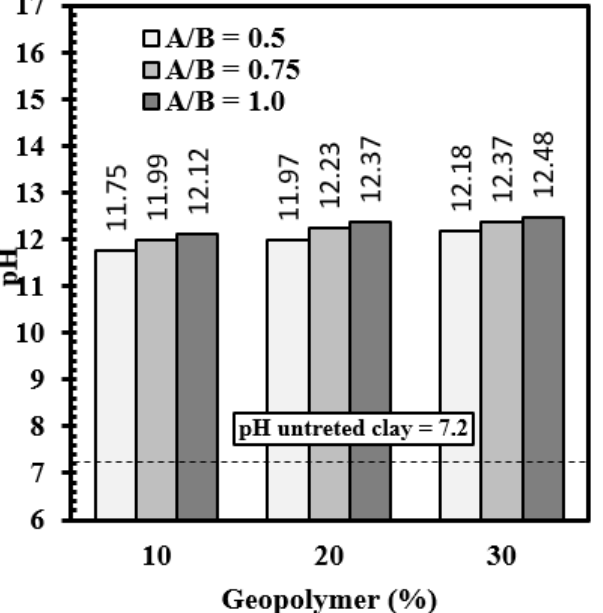
Figure 6. pH performance of clay treated with different geopolymer contents and various activator to binder (A/B) ratios.